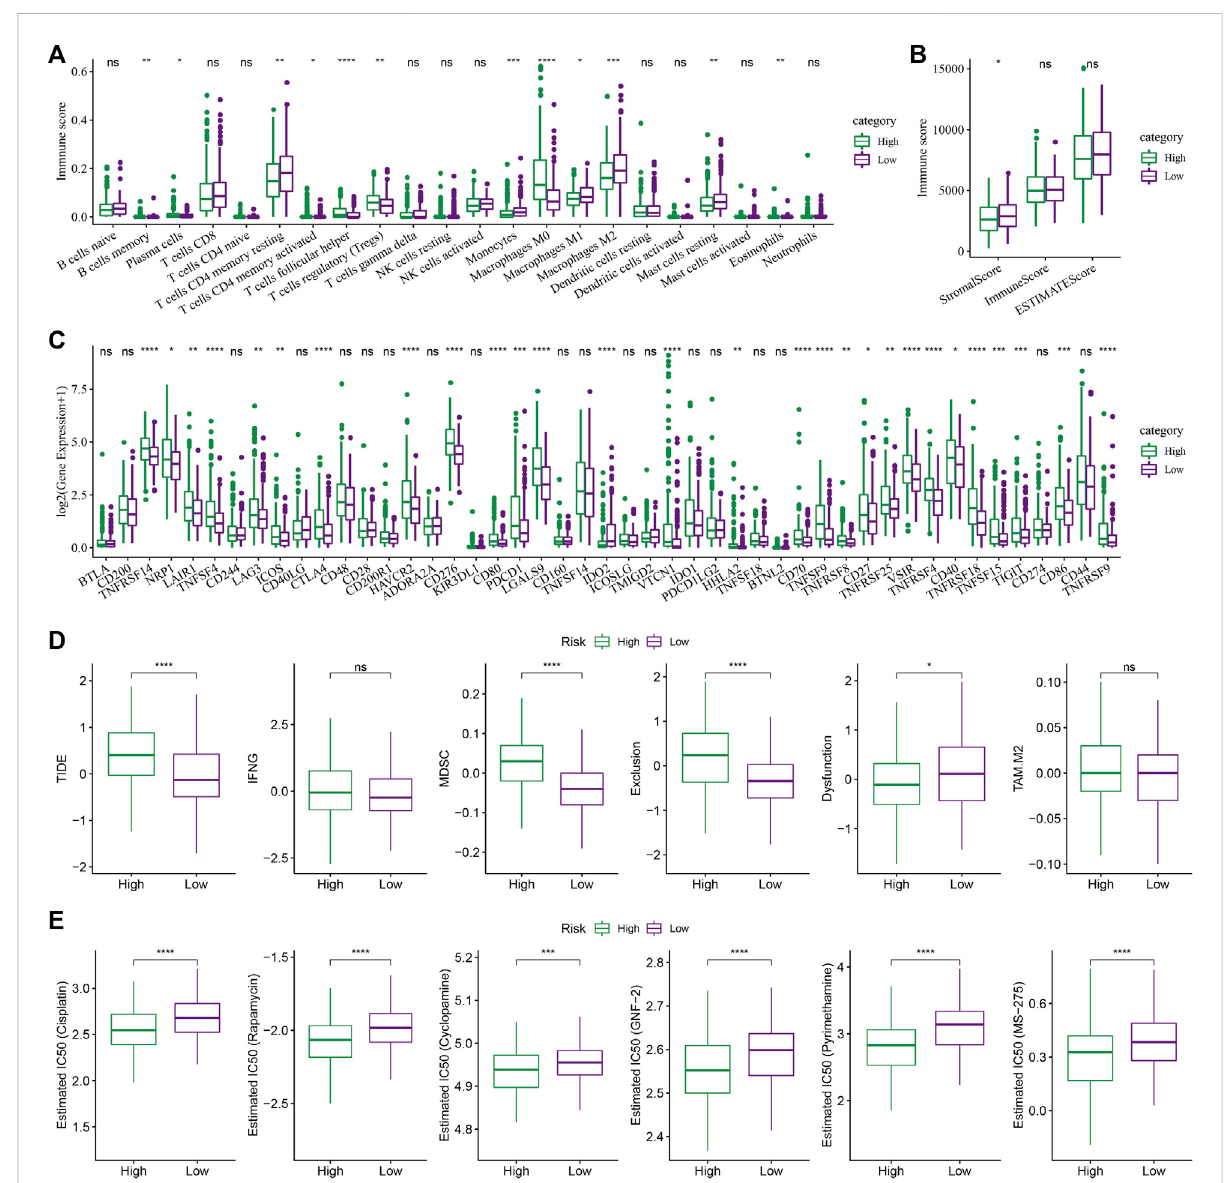
FIGURE 8 The role of the RS model in predicting the bene fi ts of immunization/chemotherapy. (A) Variations in the 22 immune cell scores amongst the different risk groups identi fi ed using the TCGA-LIHC dataset; (B) Differences in immune and matrix scores amongst the different risk groups in the TCGA-LIHC dataset; (C) Immune checkpoints differentially expressed between various groups in the TCGA-LIHC dataset; (D) The results of TIDE analysis among different groups in TCGA-LIHC dataset were different; (E) Box plots of the calculated IC50 for the drug in TCGA-LIHC